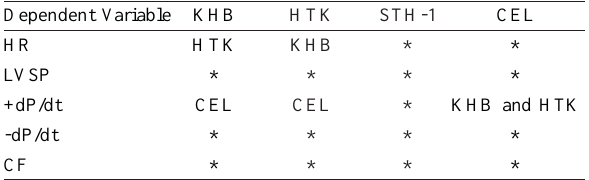
Fig. 5 - Coronary flow (CF) according to the solution. Reperfused hearts were monitored for 60 min after treatment with the following solutions: Krebs-Henseleit Buffer, Bretschneider-HTK, St. Thomas No. 1, and Celsior. Baseline was calculated after stabilization and prior to treatment Table 1. Ratio of hemodynamic variables corresponding (Tukey’s test - t60).